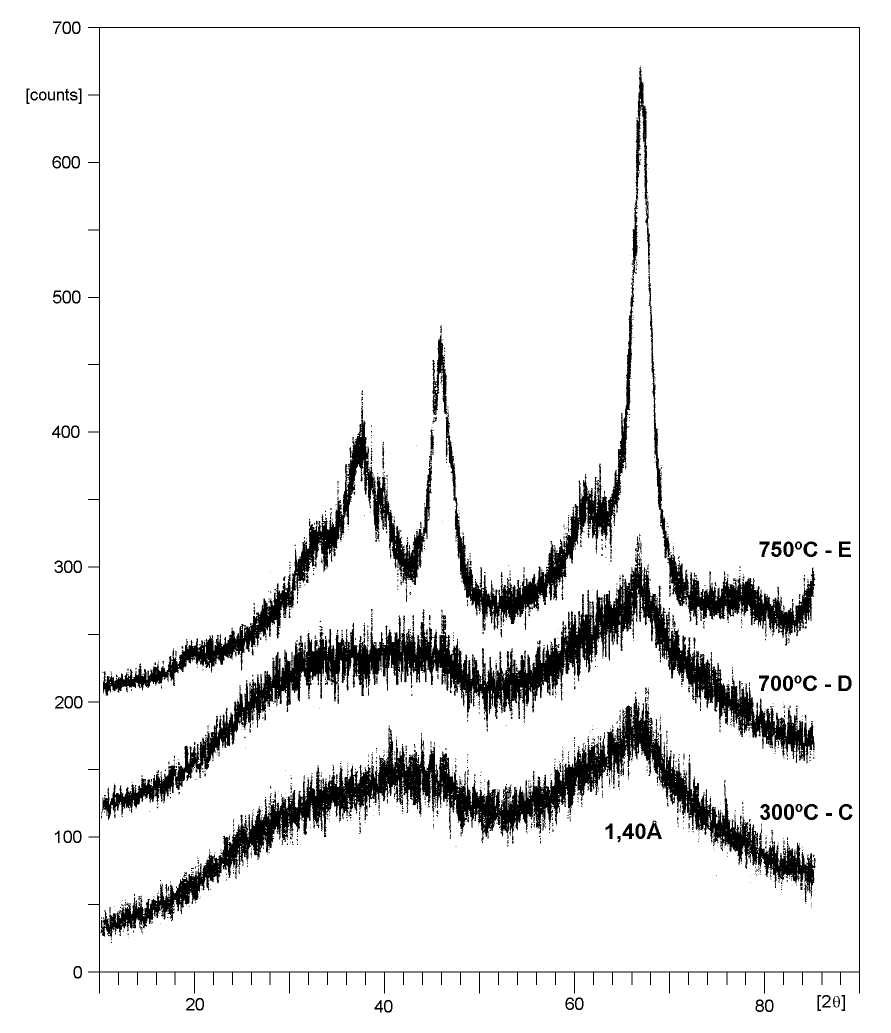
Fig. 3 – Some XRD curves of Figure 2 at lower